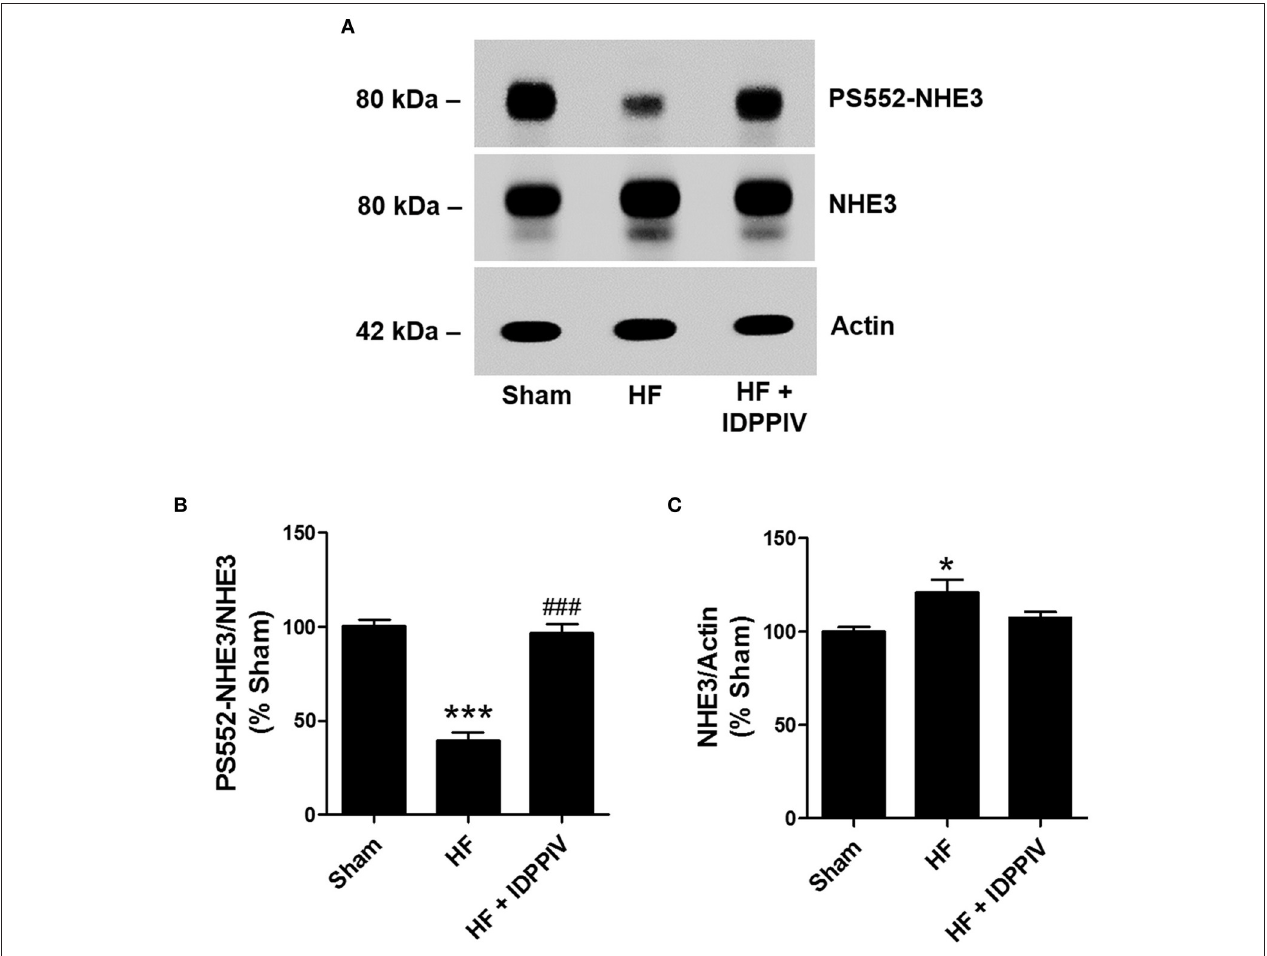
FIGURE 7 | Treatment with vildagliptin increases NHE3 phosphorylation at the PKA consensus site serine 552 in the renal cortex of HF rats. (A) Representative immunoblotting of renal cortical proteins probed with a phosphospecific NHE3 mAb that recognizes NHE3 only when it is phosphorylated at serine 552 (PS552-NHE3), total NHE3 mAb or anti-actin. (B) Graphical representation of the relative PS552-NHE3 and (C) total NHE3 levels. The relative abundance of PS552-NHE3 was quantitated by densitometry and expressed as a ratio of PS552-NHE3/total. The combined data from 4 experiments are represented. Values are means ± SEM. * p < 0.05 and *** p < 0.001 vs. Sham. ### p < 0.001 vs.